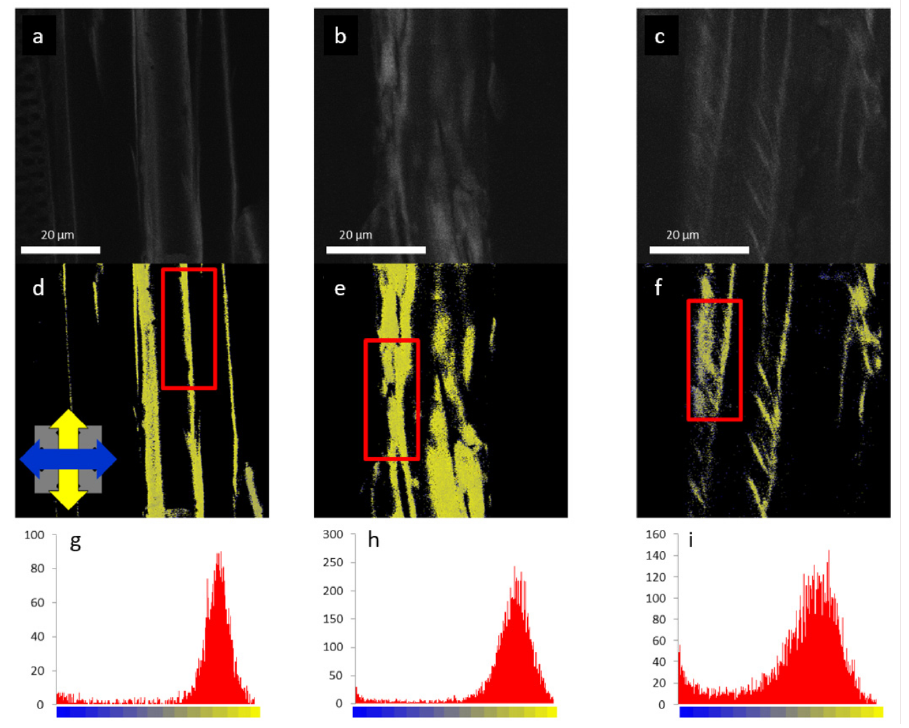
Figure 8. Confocal fluorescence intensity (upper panels) and FDLD images (middle panels) of isolated cell walls of maize ( a , d , g ), maple ( b , e , h ), and spruce ( c , f , i ) stained with Congo red; and FDLD distributions measured on the framed regions (lower panel). The blue and yellow regions in FDLD images are for the horizontal and the vertical dipole orientations, respectively. (Reproduced in colour from [51], with permission from Springer